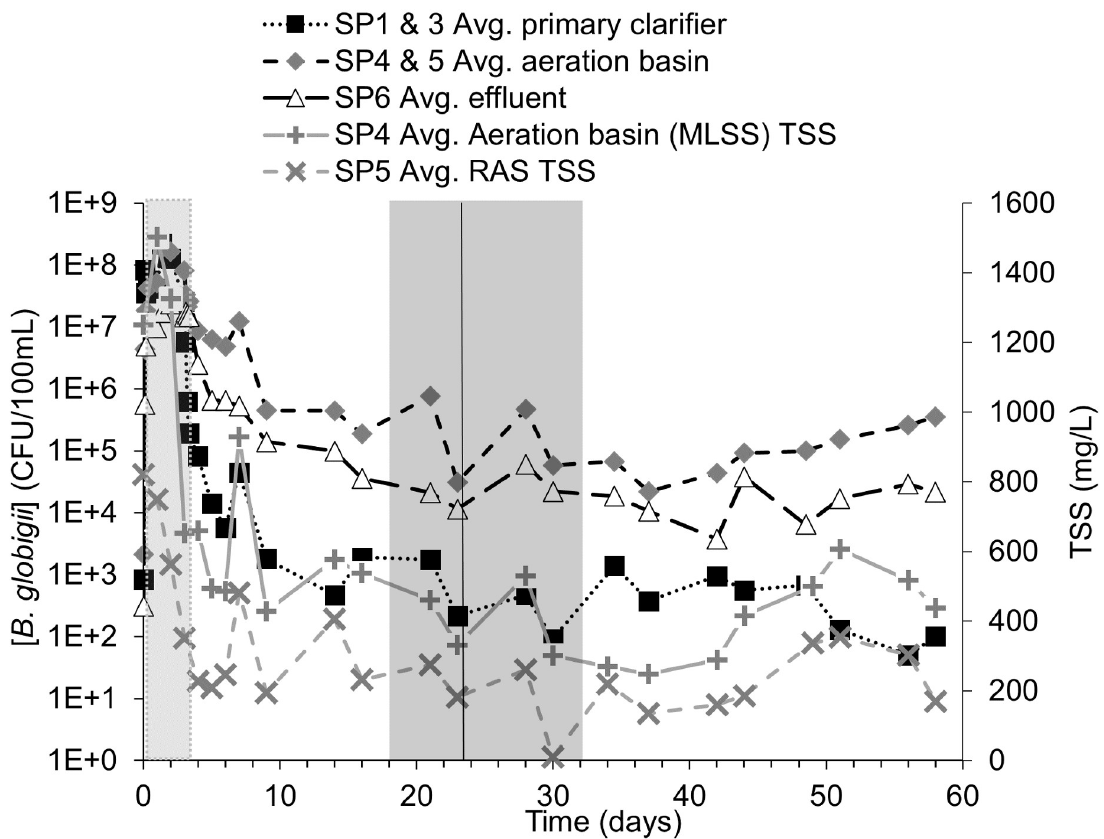
Fig 4. Averaged B . globigii concentrations and TSS in the RAS and aeration basin effluent. The light gray block shows the possible HRT range of 0.375 to 3.375 days, a black vertical line is the average calculated SRT of 23.6 ± 5.6 days, and the darker gray block represents the possible SRT range of 18–32.1 days. SP1 and SP3 from both experiments were averaged for “average primary clarifier,” and likewise for SP4 and SP5 for “Average aeration basin.” The “+” and “x” series show the TSS in the aeration basin effluent and RAS, respectfully. Error bars were removed for visual clarity. Original data in S2